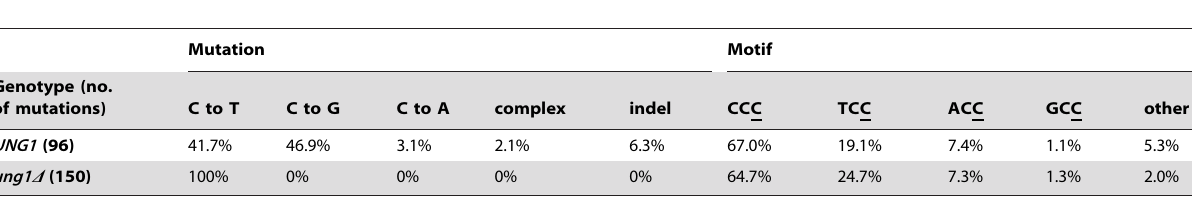
Table 1. Compilation of APOBEC3G-induced mutations (sorted by type) and APOBEC3G motif preference.